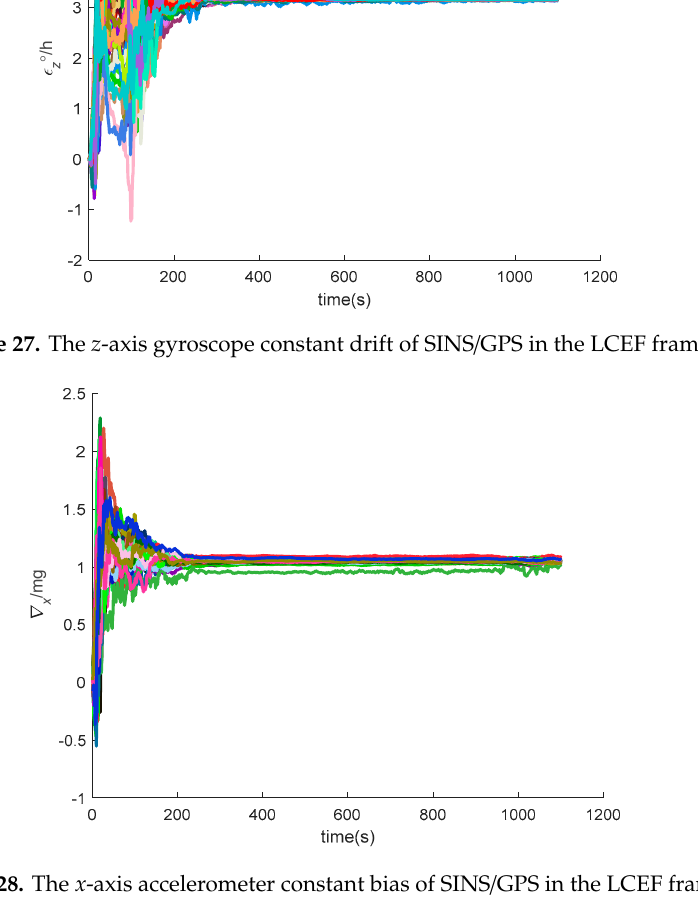
Figure 28. The x -axis accelerometer constant bias of SINS/GPS in the LCEF frame.